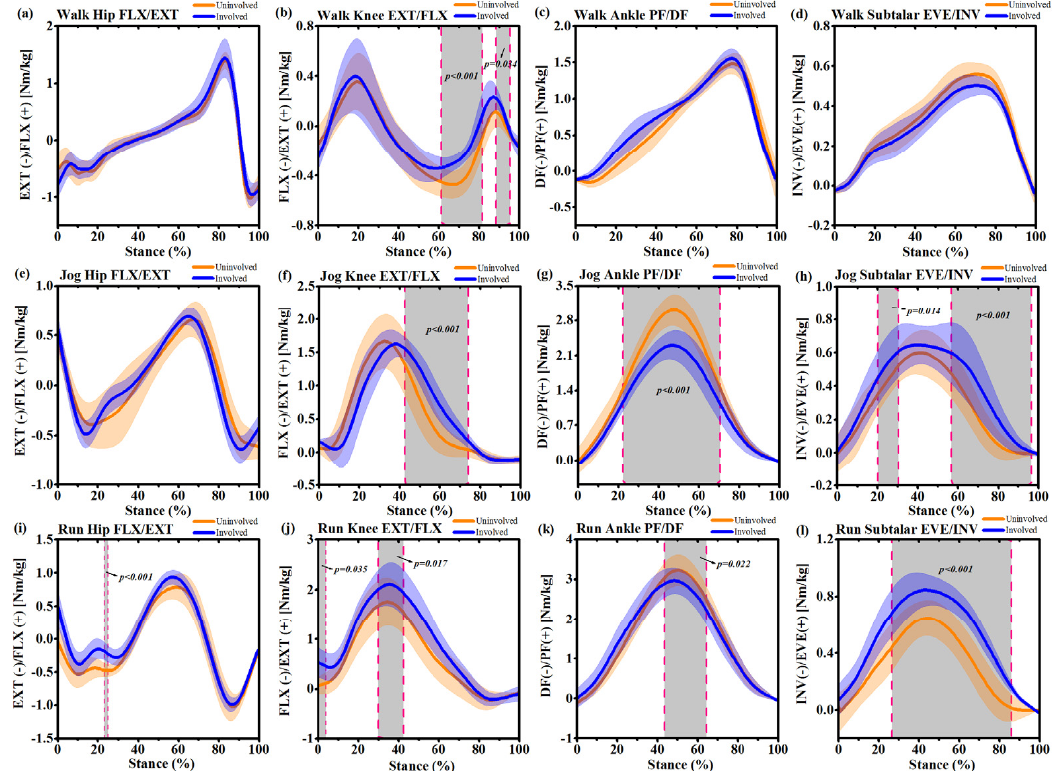
Figure 5. Mean and standard deviation of lower extremity joint moment waveforms over stance for the uninvolved side (yellow) and involved side (blue) during self-selected speed walking, jogging and running. ( a ): Hip joint flexion/extension (FLX/EXT) moment during stance phase of walking; ( b ): Knee joint flexion/extension (FLX/EXT) moment during stance phase of walking; ( c ) Ankle joint dorsiflexion/plantarflexion (DF/PF) moment during stance phase of walking; ( d ) Subtalar joint inversion/eversion (INV/EVE) moment during stance phase of walking; ( e ): Hip joint flexion/extension (FLX/EXT) moment during stance phase of jogging; ( f ): Knee joint flexion/extension (FLX/EXT) moment during stance phase of jogging; ( g ) Ankle joint dorsiflexion/plantarflexion (DF/PF) moment during stance phase of jogging; ( h ) Subtalar joint inversion/eversion (INV/EVE) moment during stance phase of jogging; ( i ): Hip joint flexion/extension (FLX/EXT) moment during stance phase of running; ( j ): Knee joint flexion/extension (FLX/EXT) moment during stance phase of running; ( k ) Ankle joint dorsiflexion/plantarflexion (DF/PF) moment during stance phase of running ( l ) Subtalar joint inversion/eversion (INV/EVE) moment during stance phase of running. Grey shaded regions on graphs indicate a significant difference between the two sides ( p < 0.05) from SPM1d analyses.